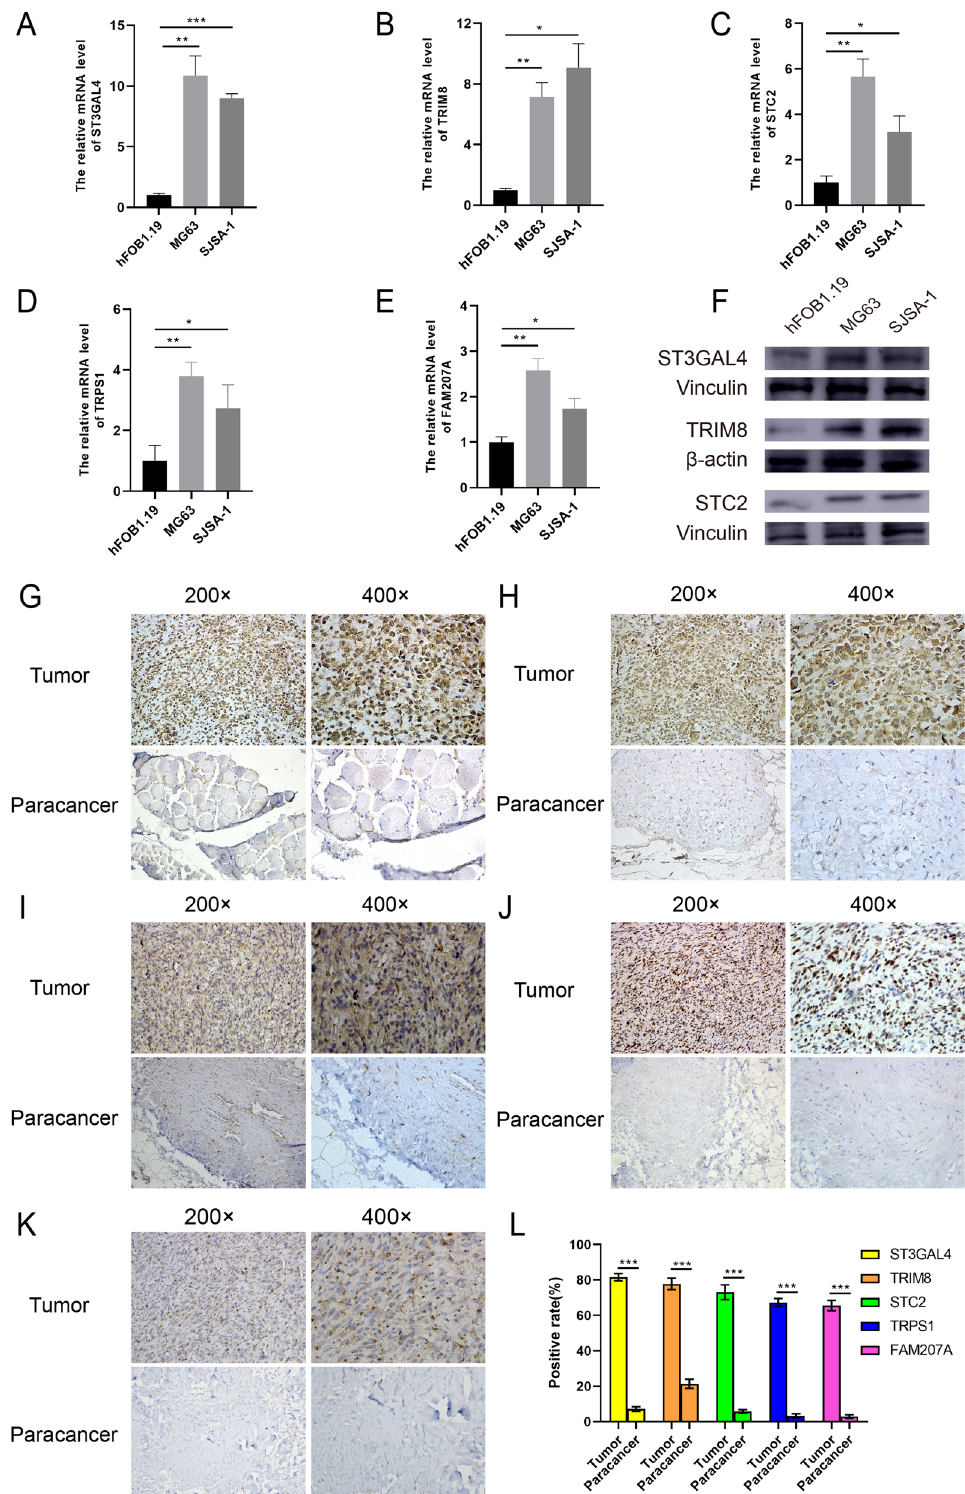
Figure 7. ST3GAL4, TRIM8, STC2, TRPS1, and FAM207A genes promote tumorigenesis in cells and patients. ( A – E ) Quantitative real-time PCR was performed to quantify the expression of ST3GAL4, TRIM8, STC2, TRPS1, and FAM207A genes in osteosarcoma cell lines (MG63 and SJSA-1) and a normal osteoblast cell line. ( F ) Western blot was performed to quantify the expression of ST3GAL4, TRIM8 and STC2 genes in osteosarcoma cell lines (MG63 and SJSA-1) and a normal osteoblast cell line. ( G – K ) The relative expression of ST3GAL4, TRIM8, STC2, TRPS1, and FAM207A genes, respectively, in the osteosarcoma tissue and the paracancerous tissues of the patient assessed by IHC. ( L ) The positive rates of ST3GAL4, TRIM8, STC2, TRPS1, and FAM207A genes in IHC pathology sections are quantified. (" * " represents P < 0.05, " ** " represents P < 0.01, and " *** " represents P <